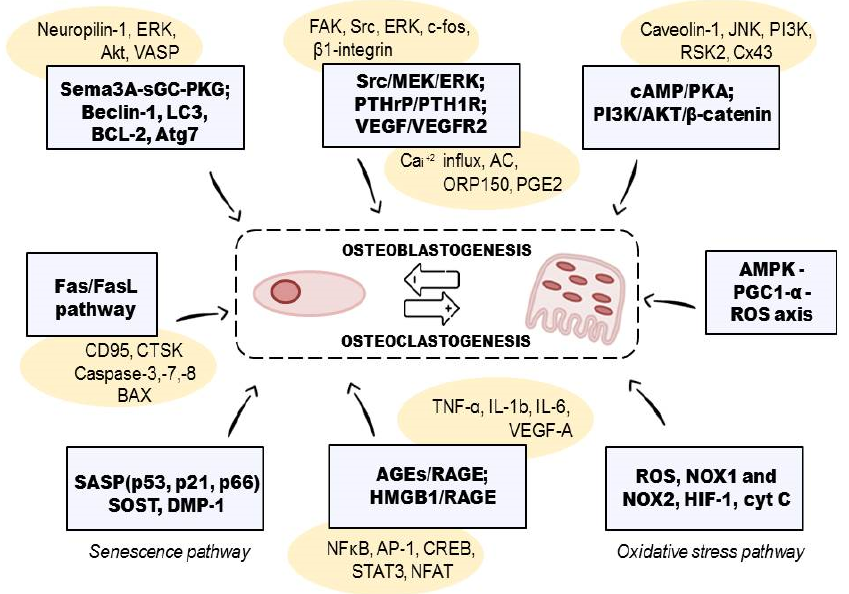
Figure 2. Molecular mechanism of bone resorption and the signaling pathways involved. SASP— senescence-associated secretory phenotype; SOST—sclerostin; DMP-1—dentin matrix acidic phos- phoprotein 1; HIF-1—hypoxia-inducible factor 1; NOX-1/2—NADPH oxidase 1/2; cyt c—cyto-